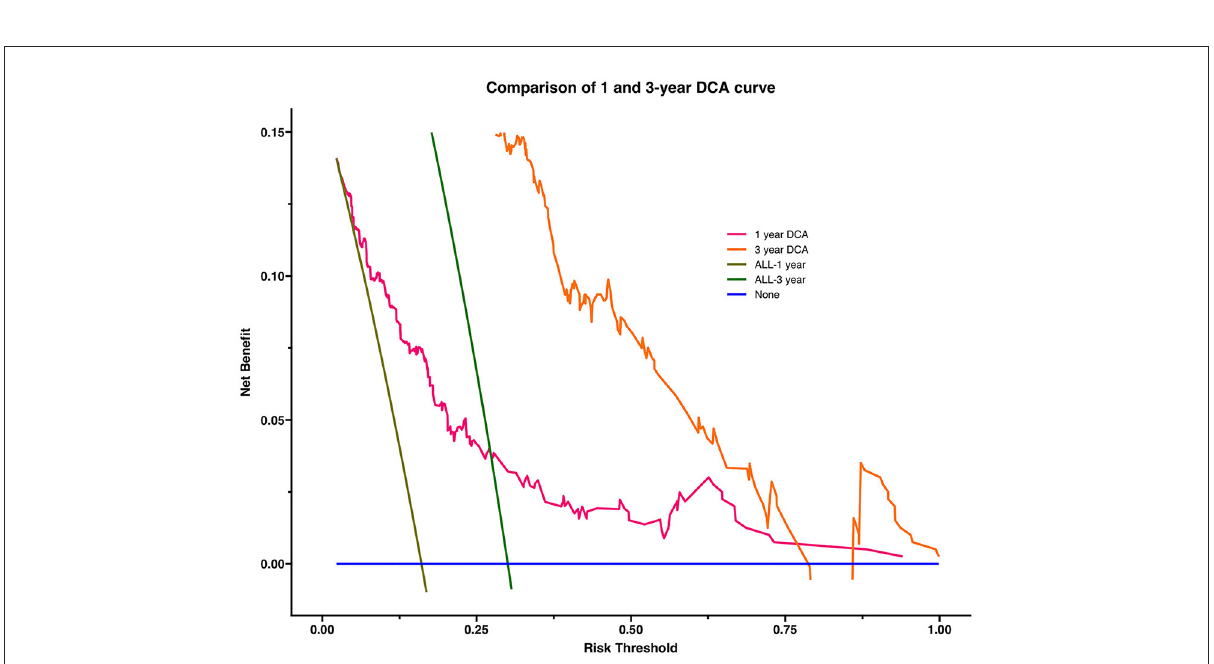
FIGURE3 Comparison of 1 and 3-year DCA: The abscissa of the graph is threshold probability (threshold probability). All line and none line are representative of one extreme state. The all line represents all patients with a bad outcome and the none line represents all patients without a bad outcome. It can be seen from the figure that both the 1-year DCA curve and the 3-year DCA curve are above the extreme line, thus illustrating that the newly constructed prediction model is of clinical utility. The area under the curve was 0.030 for the 1-year DCA curve and 0.085 for the 3-year DCA curve, so there would be some improvement in a patient’s risk of death within 3 years if interventions were required to be implemented using this